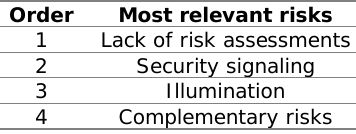
Table 10. Most relevant OSH risks in the audited companies